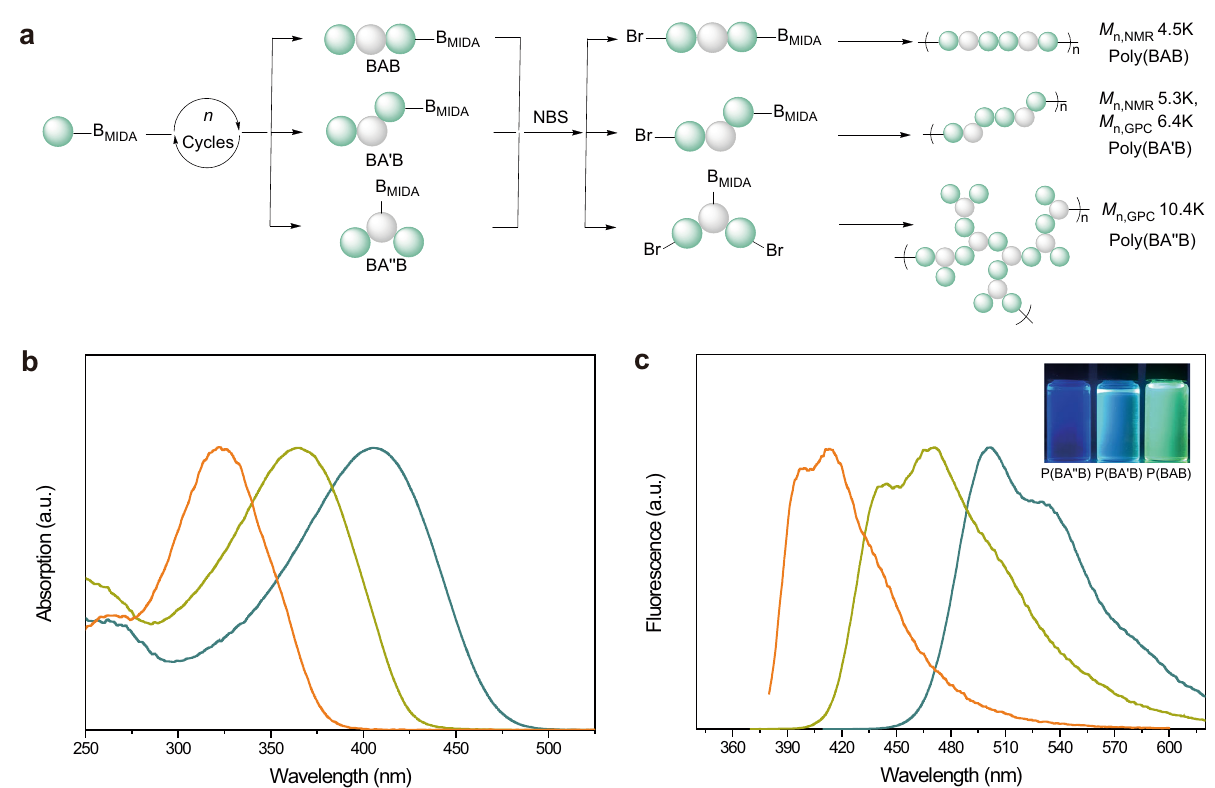
Fig. 6 Synthesis and characterization of sequence-controlled conjugated topological polymers. a Preparation of regio- and sequence-controlled conjugated topological polymers from discrete oligomers. b UV – Vis spectra of the polymers poly(BAB) (green line), poly(BA ′ B) (yellow line), and poly(BA ″ B) (orange line) dissolved in the THF. c Fluorescence-emission spectra of the polymers poly(BAB) (green line), poly(BA ′ B) (yellow line), and poly(BA ″ B) (orange line) dissolved in the THF. The fl uorescence-emission photograph inserted in Fig. 6c was taken under 365-nm ultraviolet